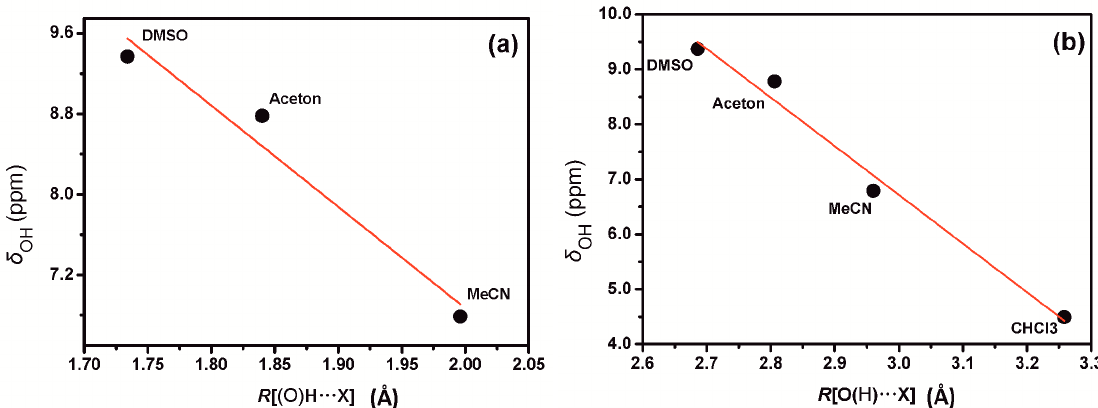
Figure 15. The dependence of the OH proton chemical shift, δ OH (ppm), in the minimum energy conformer, optimized at the DFT/B3LYP/6-311++G(d,p) level of theory, of 1:1 phenol + solvent complexes vs. R[(O)H for DMSO and acetone, X = N for MeCN, and X = C for CHCl permission from [41]. Copyright 2013, The Royal Society of